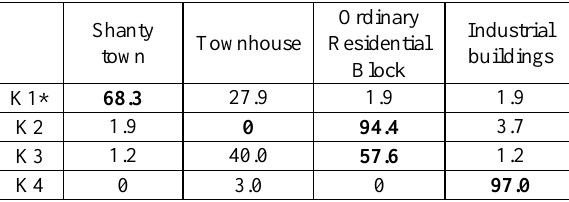
Table 3. Producer accuracy of k-means classification (%)